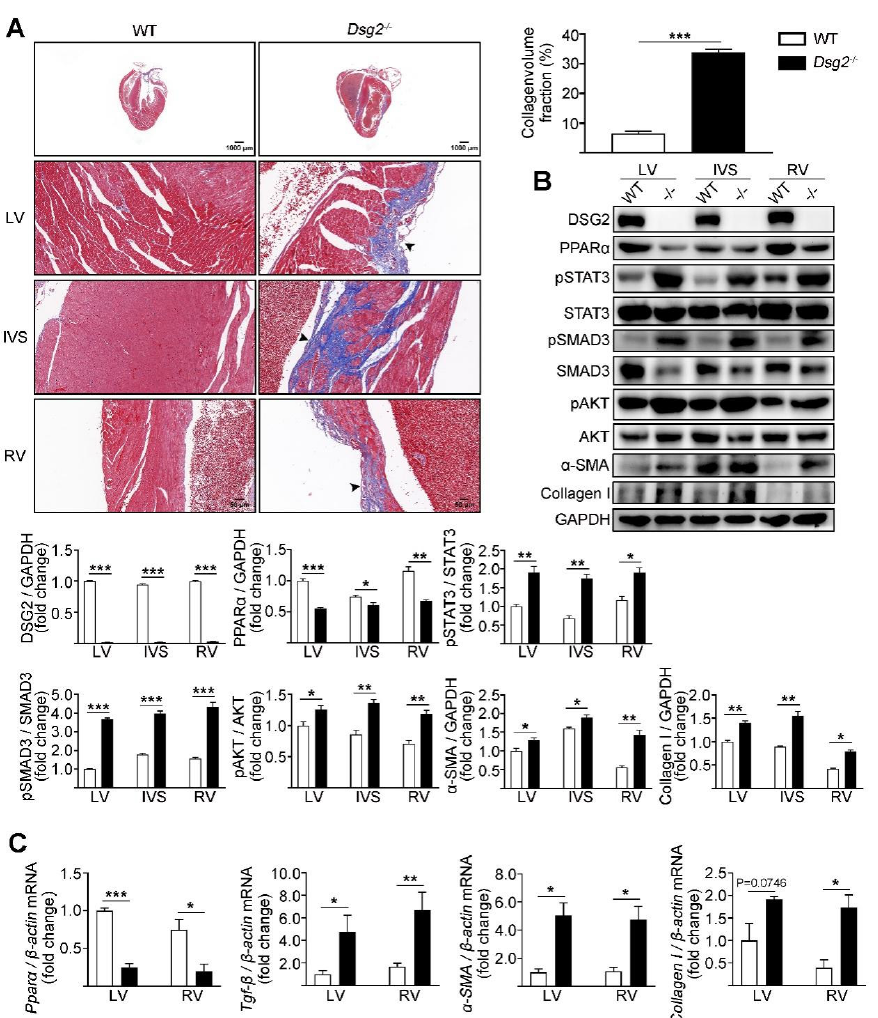
Figure 1. Cardiac-specific Dsg2 knockout induced cardiac fibrosis. ( A ) Masson staining of heart sections in WT and CS-Dsg2 − / − ( − / − ) mice. Arrow shows cardiac fibrosis. Collagen volume fraction in the hearts of WT and CS-Dsg2 − / − mice was assessed. ( B ) Representative Western blots from mouse left ventricular (LV), interventricular septum (IVS), and right ventricle (RV). DSG2, PPAR α , pSTAT3, pSMAD3, pAKT, α -SMA, and Collagen I were detected using specific antibodies. STAT3, SMAD3, AKT, and GAPDH were used as loading controls. ( C ) Results of quantitative PCR analysis of PPAR α , TGF- β , α -SMA, and Collagen I mRNA levels in mouse LV and RV are expressed as fold change of control using β -actin as loading control. Results are expressed as mean values ± SEM. n = 6. * p < 0.05, ** p < 0.01, *** p < 0.001 vs. WT. The effects of Dsg2 on STAT3 activity and fibrosis were assessed in the cardiac myo- cyte cell line HL-1. To silence the expression of Dsg2 and Stat3, HL-1 cells were transfected with Dsg2 siRNA and Stat3 siRNA. The knockdown efficiency of Dsg2 siRNA was 66% and 51% for Stat3 siRNA. Consistent to the in vivo study, knockdown of Dsg2 in the HL- 1 cells led to an increase in the phosphorylation of STAT3 (Tyr705) and the expression